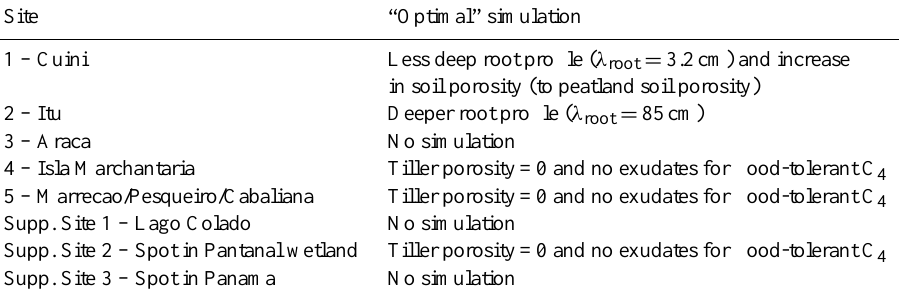
Table 4. Description of the “optimal” simulation for each site. For each site, the “optimal” simulation has to be compared to the site’s simulation no. 5 (Table 3). According to Wania et al. (2010), the root profile is defined by C root e z/λ root , where C root is a normalization constant to give a total root biomass of 100% within 2m depth. Optimal simulation for sites 1 and 2 corresponds to a modification of the λ root value.